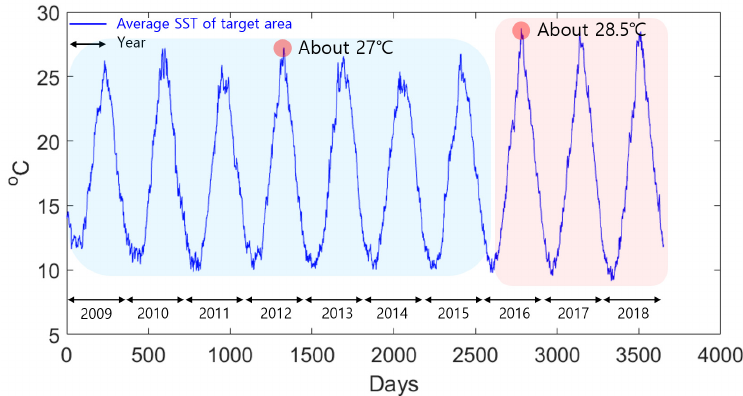
Figure 2. Time series of average SSTs in the target area shown in Figure 1.